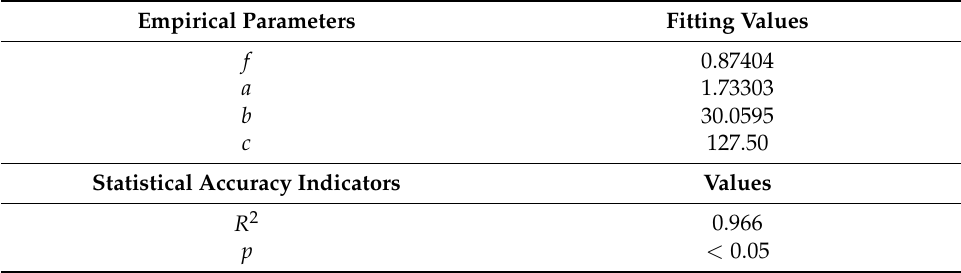
Table 1. Fitting parameters to predict Nu from Ha number and inclination angle θ at Ra = 10 4